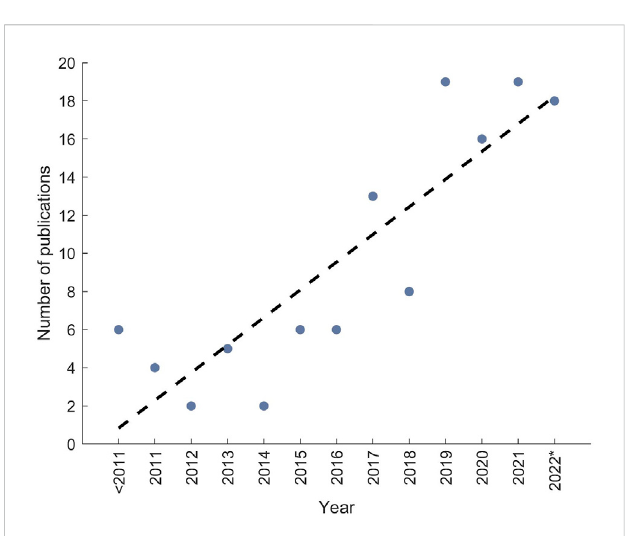
FIGURE 5 Number of publications arranged according to the year of publicationoftheincludedpaperstotheliteraturereview,thedottedline is the trend of publications; 2022* indicates that literature is only considered that has been published to the date of literature